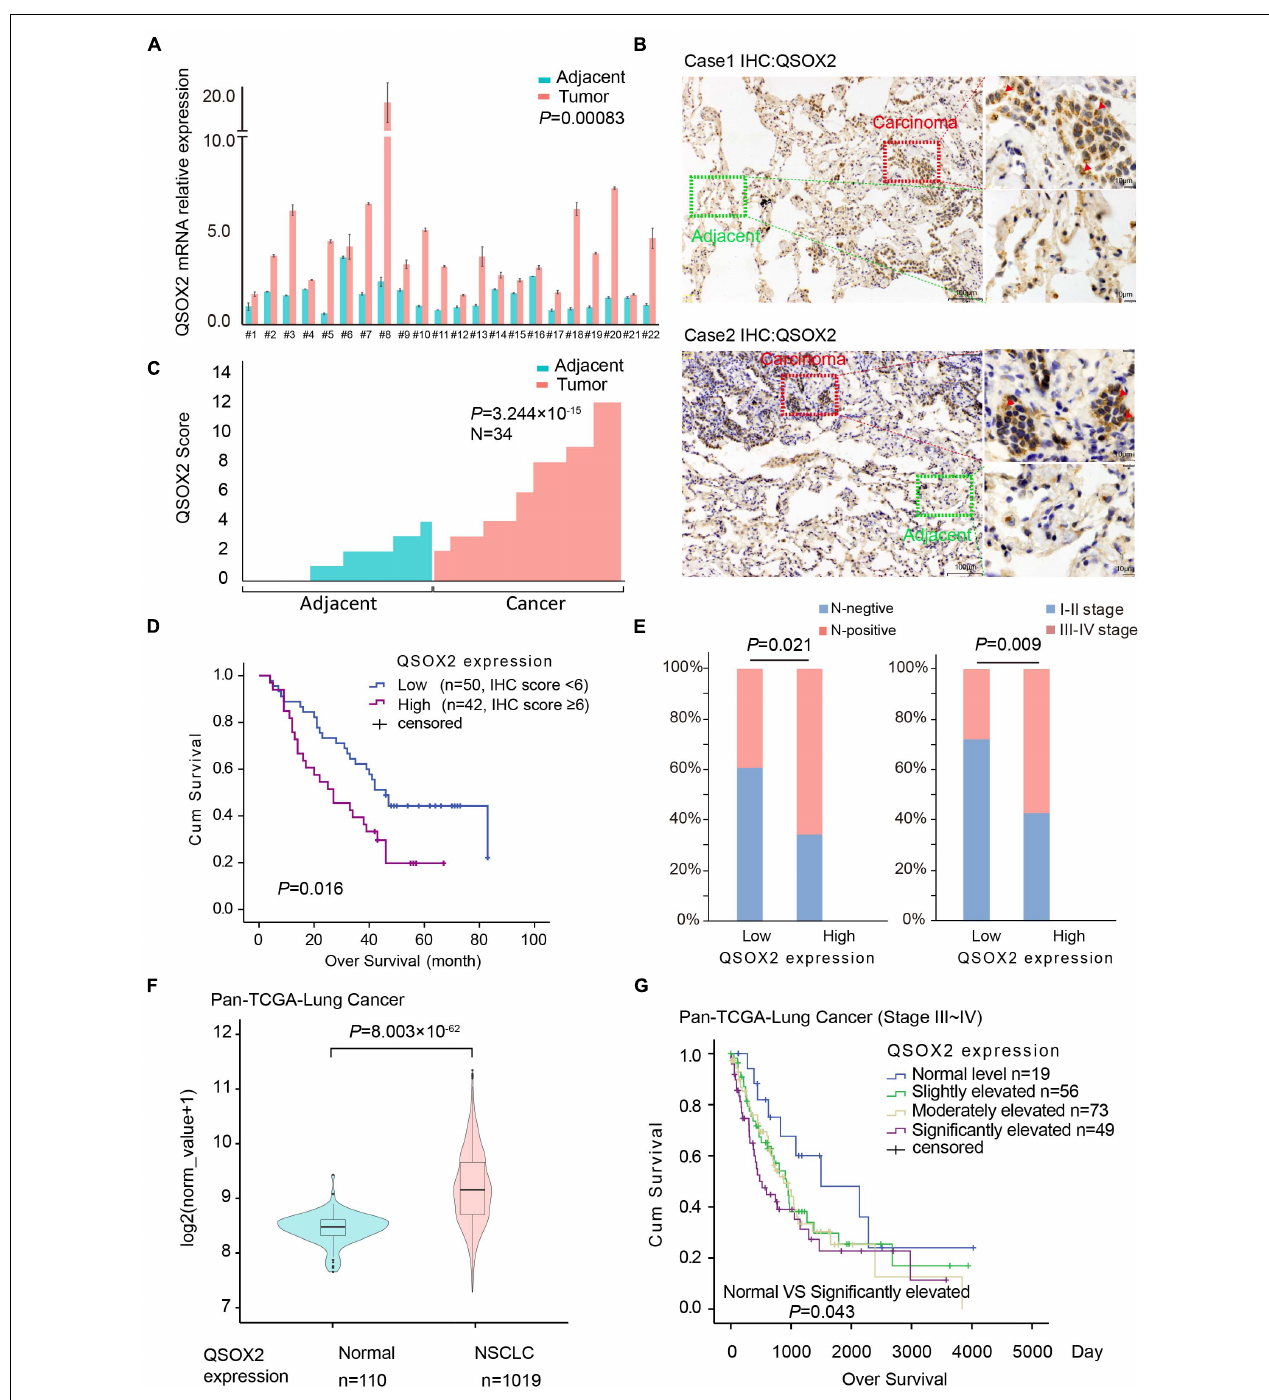
FIGURE 1 | Quiescin sulfhydryl oxidase 2 ( QSOX2 ) is highly expressed in NSCLC and correlates with prognosis. (A) Twenty-two pairs of resected frozen tissue samples were subjected to real-time PCR analysis for QSOX2 expression (cohort 1). (B) IHC detection of QSOX2 expression in representative NSCLC samples and matched adjacent normal lung tissue samples ( n = 34, cohort 2). The areas of carcinoma and adjacent tissues are indicated. The red arrow head represents QSOX2. (C) The expression of QSOX2 according to the IHC score. Statistical significance was analyzed using the Wilcoxon matched-pairs signed-rank test. (D) Kaplan-Meier analysis of the overall survival of 92 NSCLC patients (data from TMA cohort 3). (E) IHC results revealed that the expression of QSOX2 was positively correlated with TNM stage and lymph node metastasis status in NSCLC. (F) Violin plot comparing the expression of QSOX2 between NSCLC and non-tumor tissue samples from the TCGA dataset. (G) Kaplan-Meier survival curves plotted by R Studio (survival package) according to the different expression levels (normal, slightly elevated, moderately elevated, and significantly elevated) of QSOX2 in stage III–IV NSCLC samples.